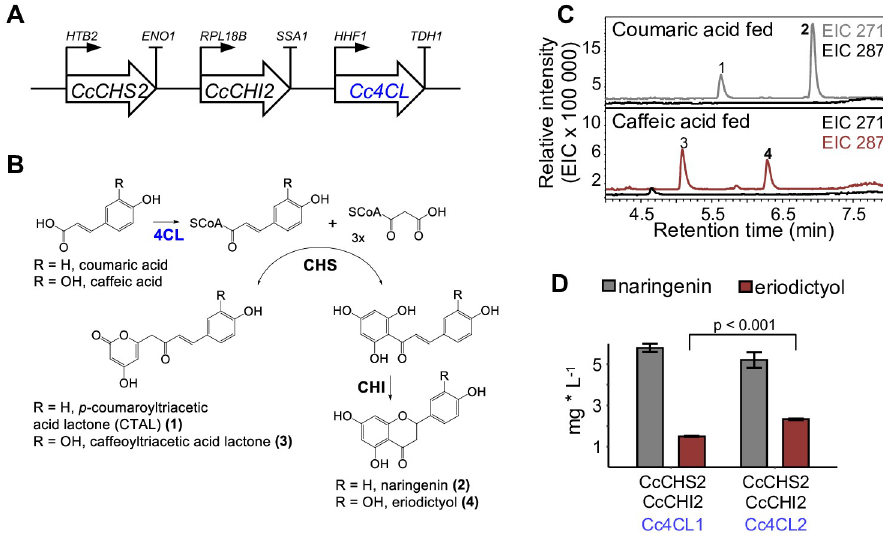
Fig 6. Reconstruction of flavanone biosynthesis in Saccharomyces cerevisiae using montbretia 4CLs . (A) Flavanone biosynthesis module. For expression in S . cerevisiae , expression modules containing montbretia chalcone synthase ( CcCHS2 ), chalcone isomerase ( CcCHI2 ) and one of two 4-coumaroyl CoA ligases (4CLs), montbretia Cc4CL1 or Cc4CL2 , were constructed. (B) Schematic representation of flavanone biosynthetic pathway. Coumaric acid or caffeic acid are converted into naringenin or eriodictyol, respectively. Lactone formation occurs as a side reaction. (C,D) Engineering flavanone production in S . cerevisiae . Flavanone biosynthesis modules (see A) differing in their Cc4CL genes were heterologously expressed in S . cerevisiae . Genes were constitutively expressed from the same low copy plasmid. Yeast cultures were grown for 67h in 48-well plates, extracted and analysed for flavanone formation using LC-MS. Representative extracted ion chromatograms (EIC) (C) and amounts of produced naringenin or eriodictyol are shown (n = 2) (D). Peak 1, tentatively identified as p -coumaroyltriacetic acid lactone; peak 2, naringenin; peak 3, tentatively identified as caffeoyltriacetic acid lactone; peak 4, eriodictyol. Changes in flavanone levels were tested using Welch’s two-sample t-tests (naringenin: p = 0.27; eriodictyol: p <